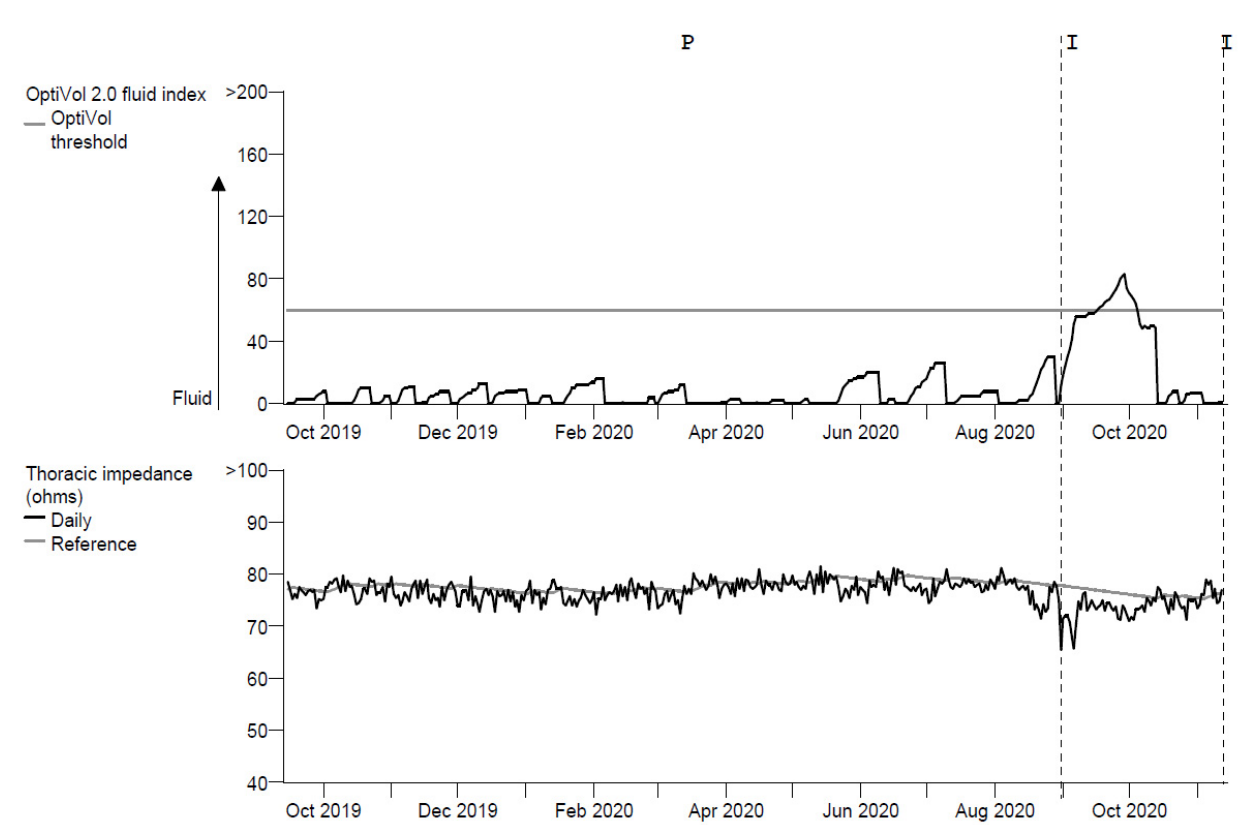
Figure 2. Trend of the OptiVol 2 fluid index and the daily measured intrathoracic impedance (Ohms). The threshold of the fluid index is at the nominal value of 60 (gray horizontal line).